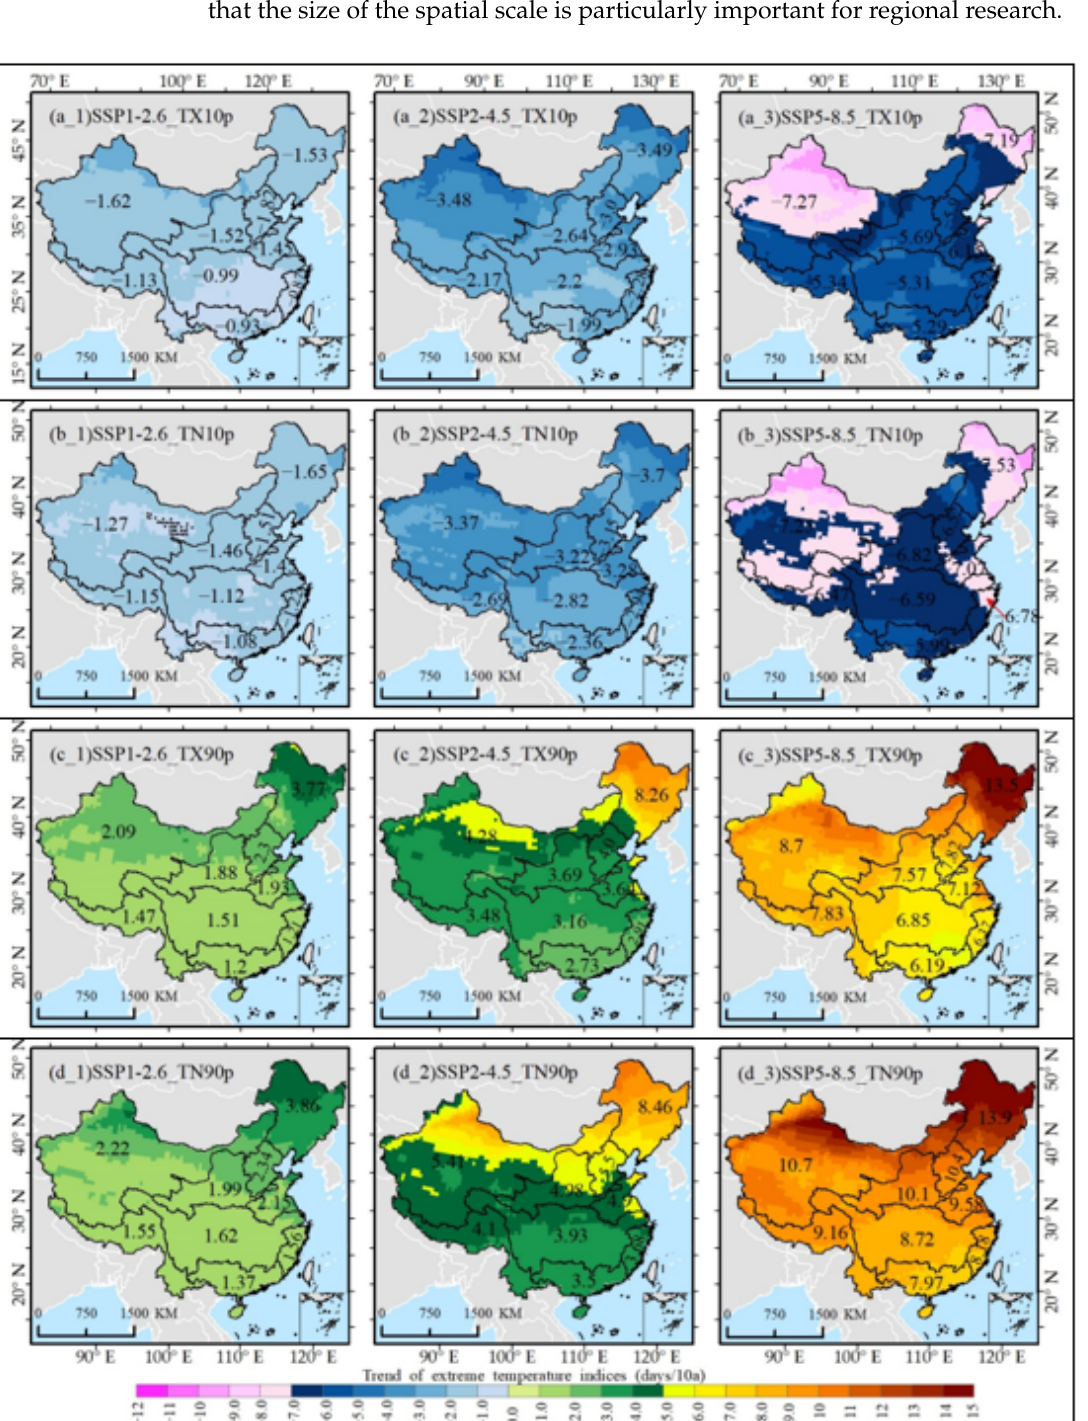
Figure 8. Spatial distribution of the trend of ( a_1 ) SSP1-2.6_TX10p, ( a_2 ) SSP2-4.5_TX10p, ( a_3 ) SSP5-8.5_TX10p, ( b_1 ) SSP1-2.6_TN10p, ( b_2 ) SSP2-4.5_TN10p, ( b_3 ) SSP5-8.5_TN10p, ( c_1 ) SSP1-